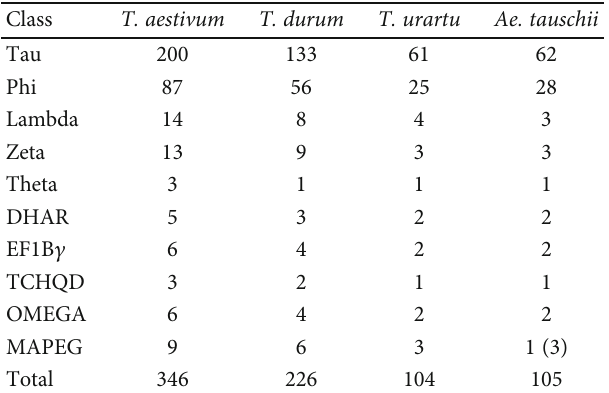
Table 1: Number of glutathione S-transferase genes identi fi ed in wheat and its